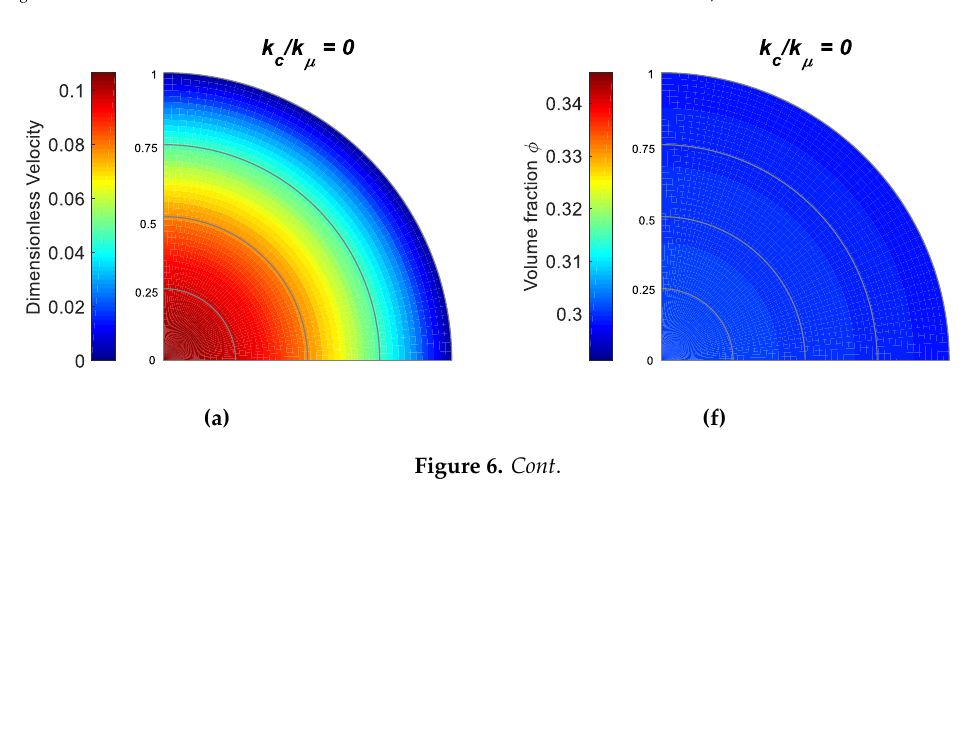
Figure 5. Effect of 𝐾 𝑐 on ( a ) the velocity; and ( b ) the volume fraction profiles, with 𝛽 = 1.82, 𝜙 𝑎𝑣𝑔 = 0.3, 𝑅 0 = 0.1, 𝑅 1 = − 2.5, 𝑅 2 = 0.1, 𝑅 3 = 0.01, 𝑅 4 = 0.07, 𝑅 5 = 1.8, 𝜙 𝑚 = 0.65, 𝑚 = 1, 𝜃 = 45 o .